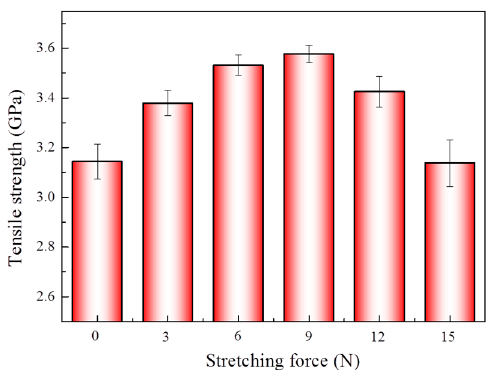
Figure 5. Tensile strength of the fiber under different tensile forces in pure scCO 2 , under stretching forces of 0, 3, 6, 9, 12, and 15 N, with the same conditions of sample 2 in Table 1. At least 60 samples were tested for all specimens. The vertical bars represent the standard deviations.